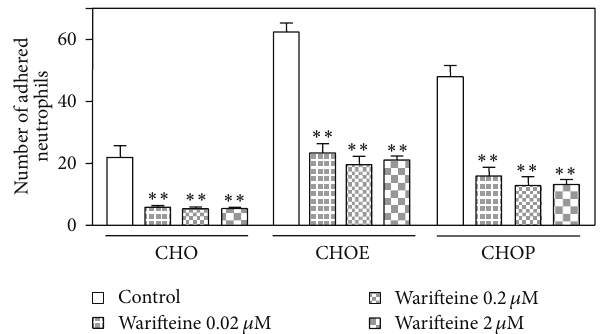
Figure 6: Adhesion of neutrophils to CHO cells and to CHO cells expressing P and E selectin. CHO cells transfected with either P (CHOP) or E selectin (CHOE) genes were used. A cell monolayer wasobtainedbyovernightincubationofnormalortransfectedCHO cells in coverslips. Peritoneal exudate neutrophils were obtained and treated with warifteine in vitro . Those cells were then transferred to the monolayers of CHO cells and incubated. Coverslips were removed, washed with PBS, and Giemsa-stained. They were ana- lyzed by optical microscopy. The number of neutrophils adhered to CHO cells was scored. The graphs shown indicate the mean values from four independent experiments performed in triplicate. ∗∗ 𝑃 ≤ 0.05 in the comparison of cultures treated with warifteine (in different concentrations) and cultures treated with medium only without